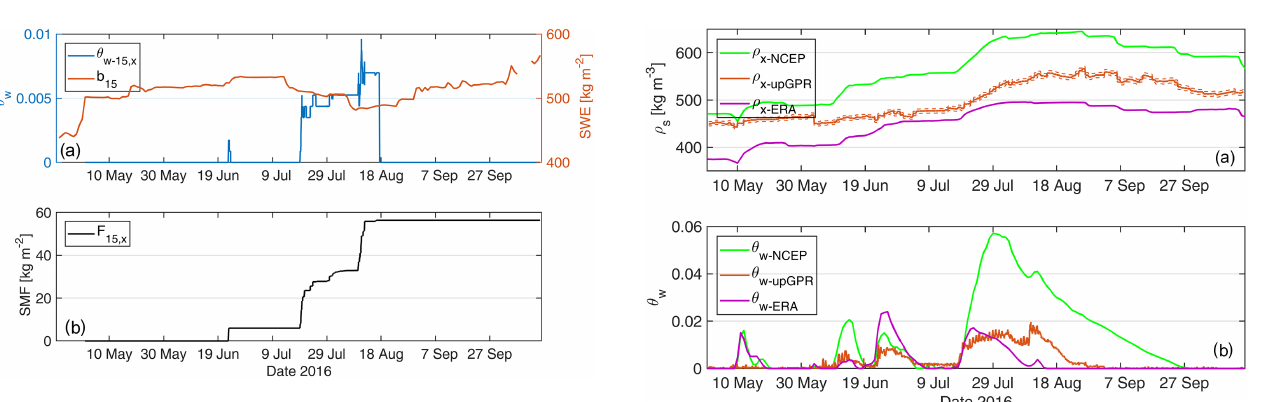
Figure 6. (a) Mass balance estimates for the snow layer above the summer horizon 2015 (brown line, right axis) and changes in θ w of the layer between the summer horizon of 2015 and the reference horizon (blue line, left axis). (b) Seasonal mass flux (SMF) that has percolated through the 2015 summer horizon into firn below.